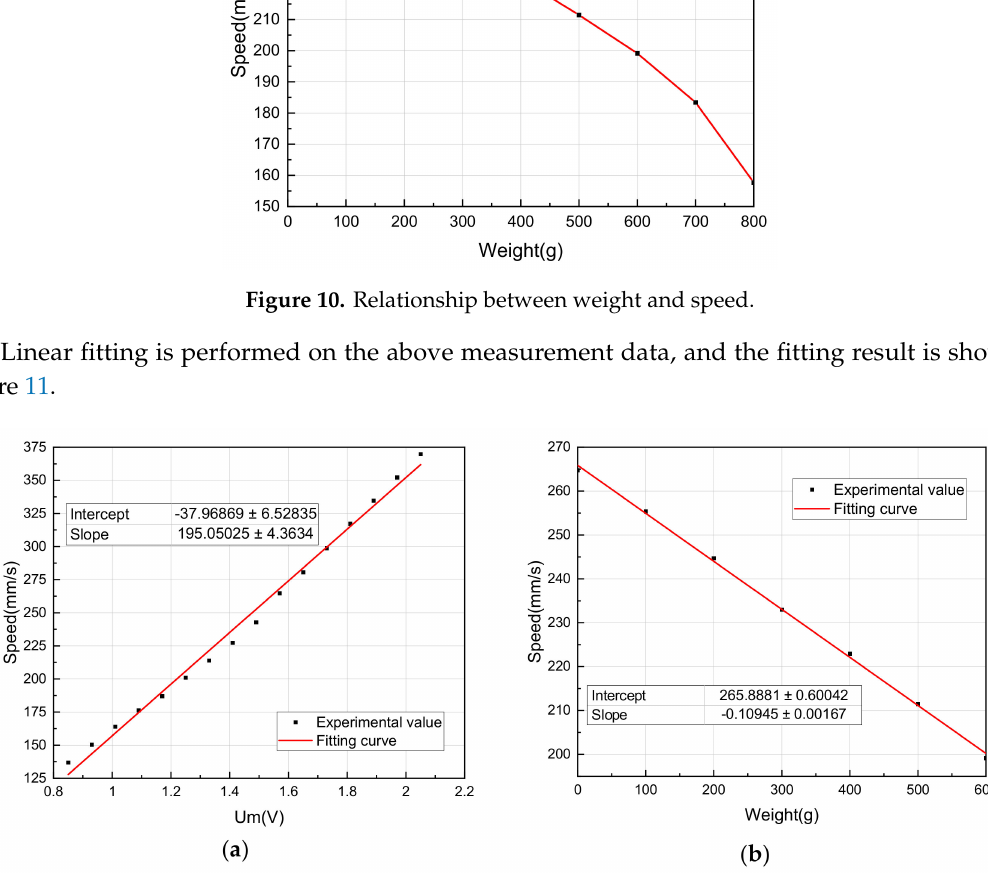
Figure 11. ( a ) Stator vibration amplitude-speed and ( b ) output force-speed